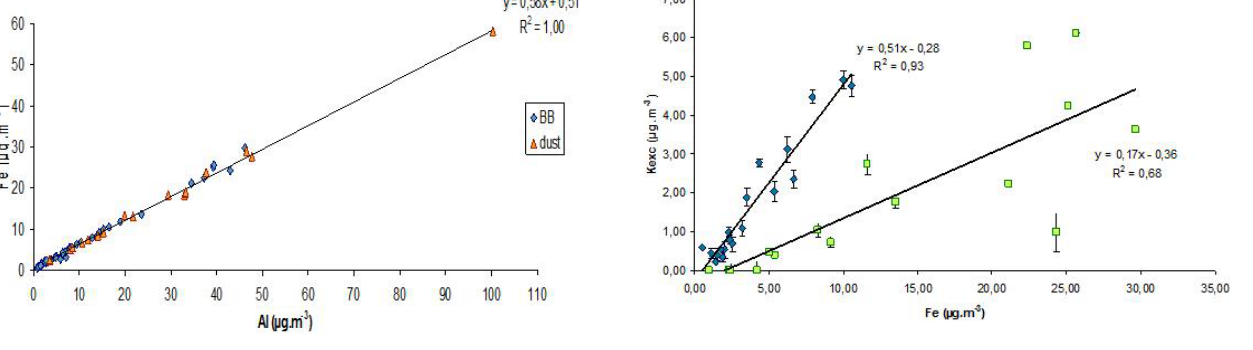
Fig. 1. Total Fe vs. Total Al for the entire DUST and BB aerosol samples.